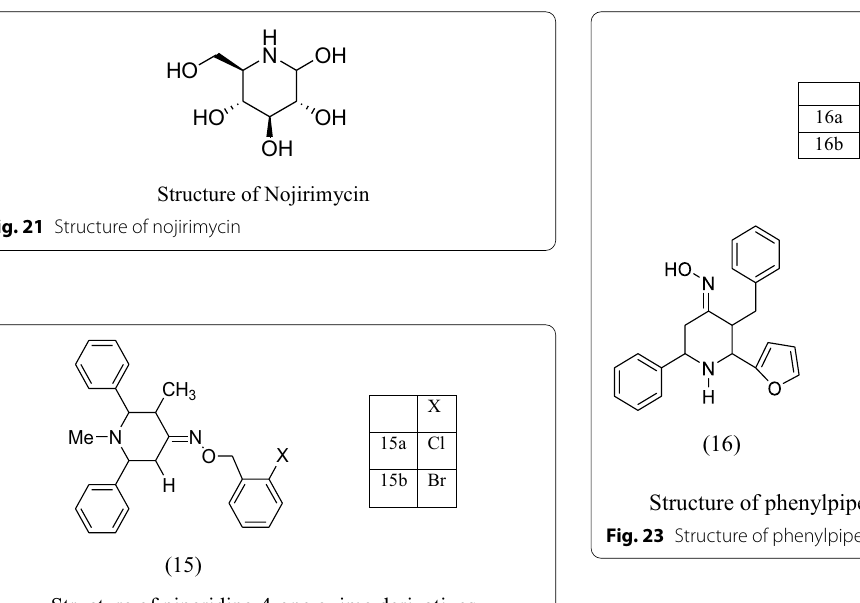
Fig. 22 Structure of piperidine‑4‑one oxime derivatives